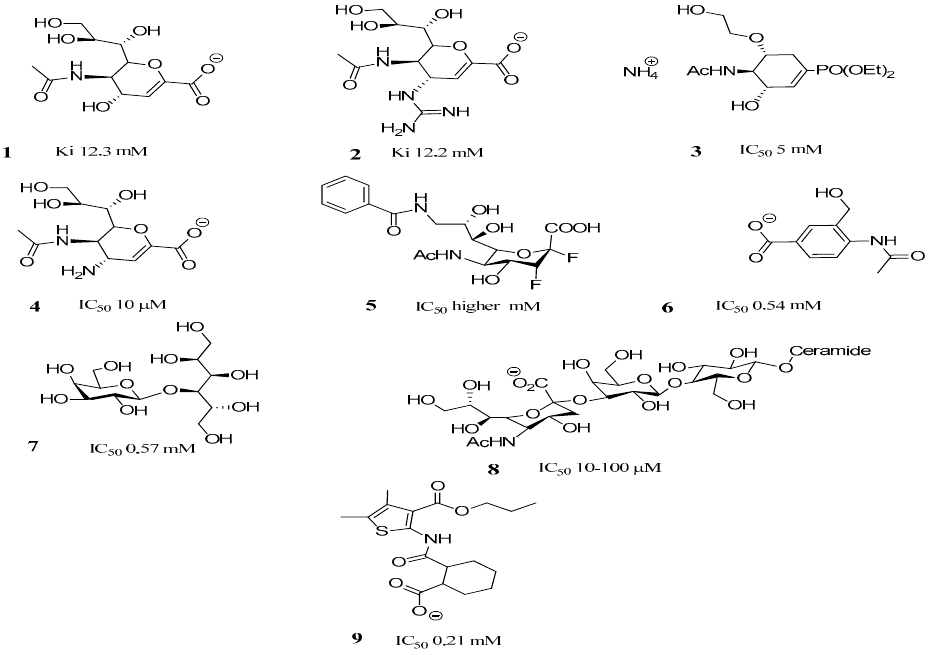
Figure 2. Structure of representative trans -sialidase inhibitors.